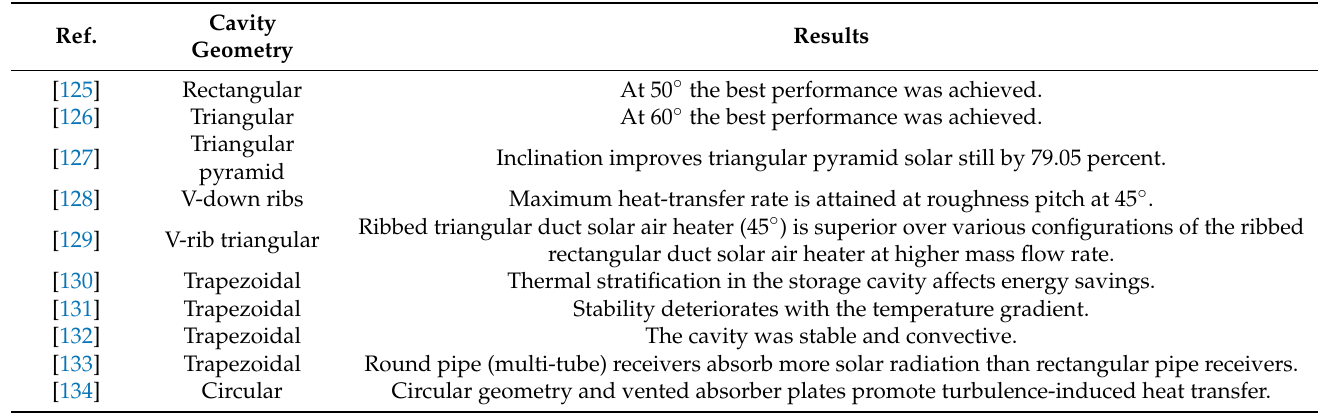
Table 4. Different shapes of cavities used in solar